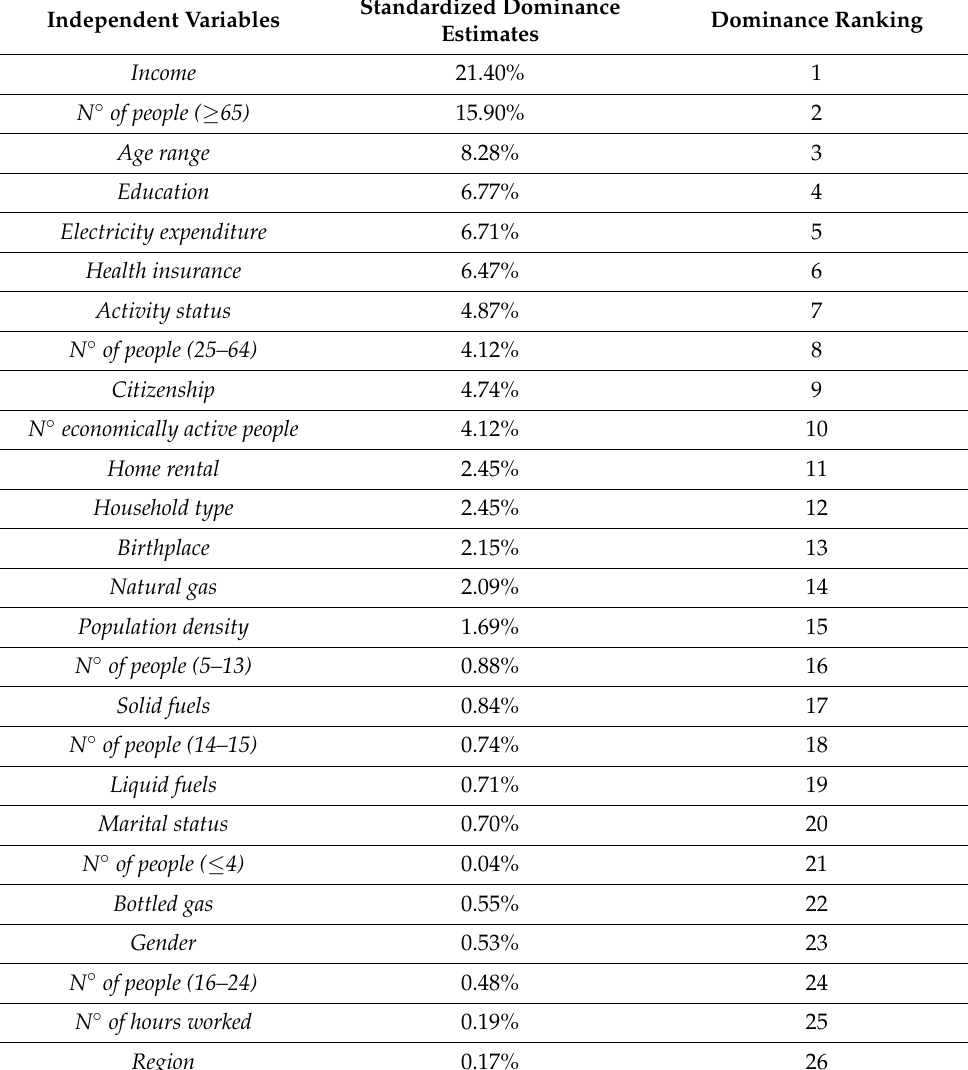
Table 4. Top 5 ranking for dominance